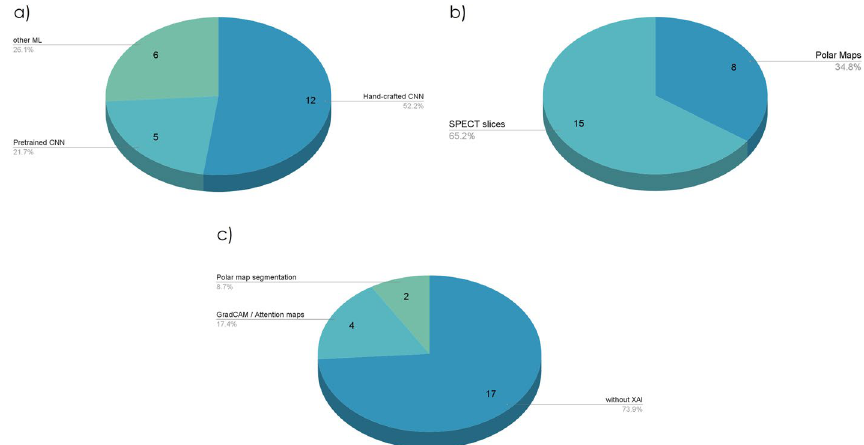
Fig. 8 Proportion of diagnosis classification studies in terms of: a learning type employing pretrained networks and hand-crafted networks, b data source employing SPECT images and Polar Maps, and c explainability employing GradCAM, attention maps, polar map segmentation techniques or without any XAI